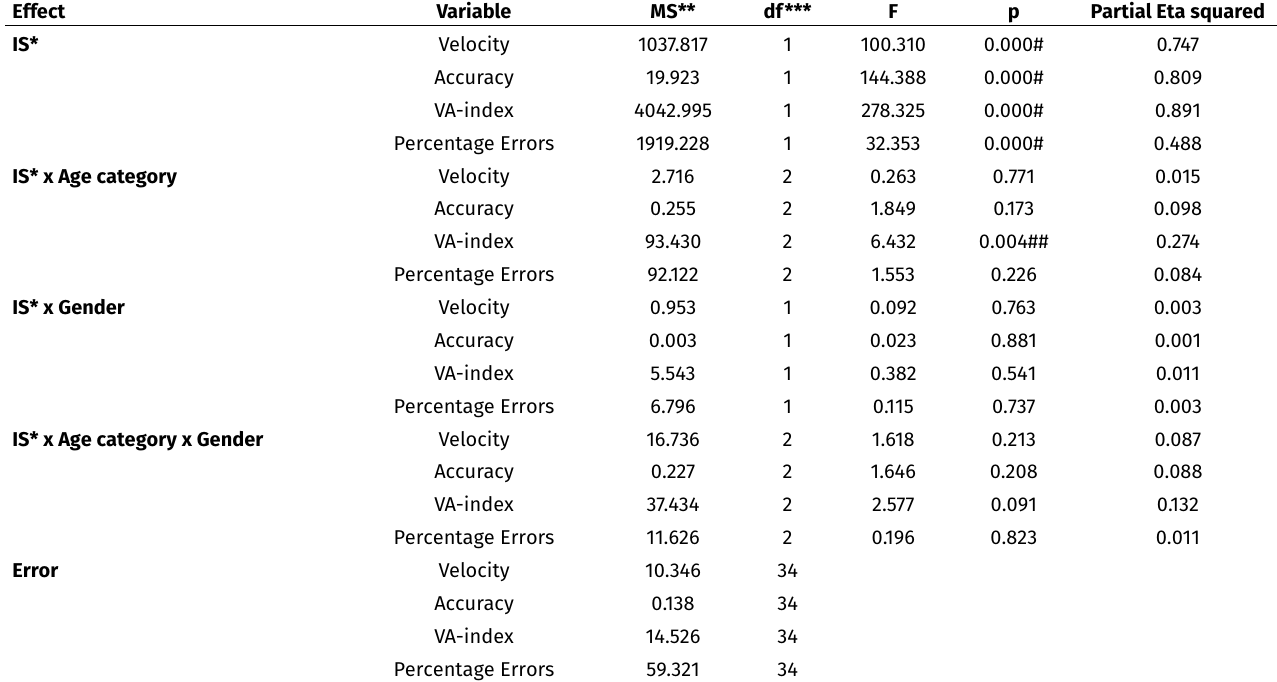
Table 4. Repeated Measures MANOVA Test of Within-Subjects Effects for technical performance in the PTTF-test.